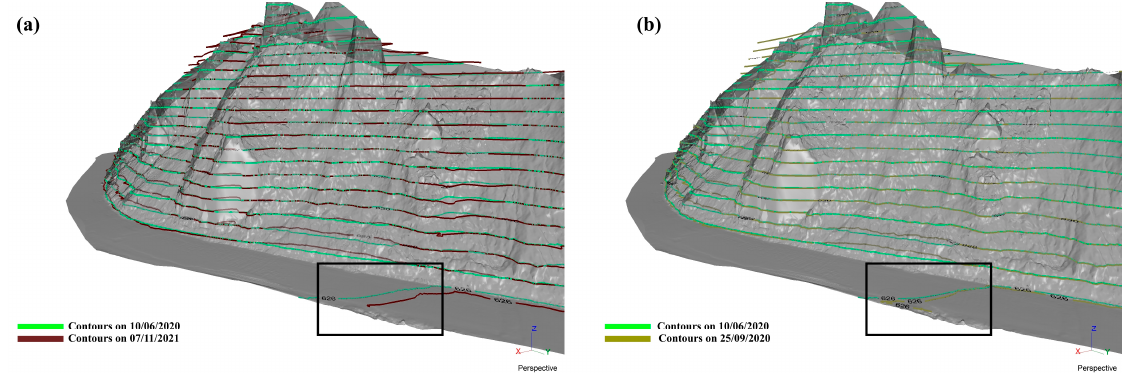
Figure 14. ( a ) Contours of the 3D TLS representations acquired on 10 June 2020 and 7 November 2021. ( b ) Contours of the 3D TLS representations acquired on 10 June 2020 and 25 September 2020. The black boxes surround the micro-movements along the road area.